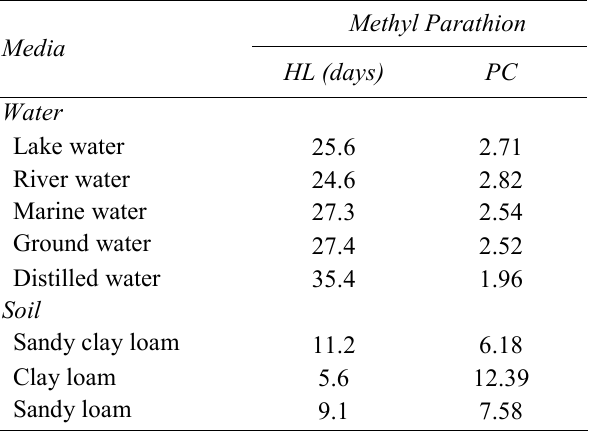
Table 2: Half life (days) and photolysis constants of methyl parathion in selected water and soil [31]